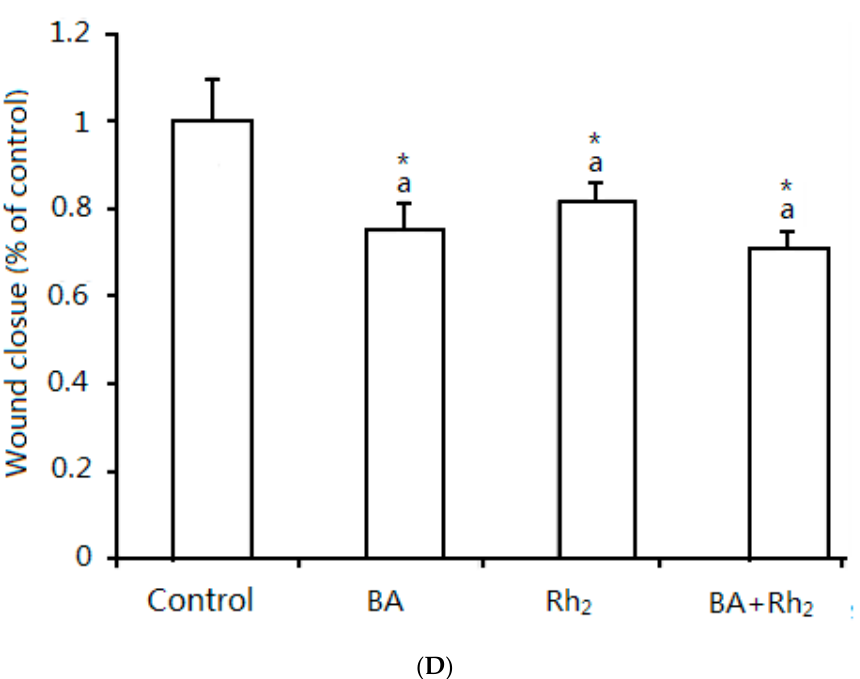
Figure 2. For the scratch assay, wounds were made when MDA ( A , B ) and MCF-7 ( C , D ) cells were 90–100% confluent and after an overnight starvation. Cells were treated with vehicle control, 63.76 μ M BA, 57.53 μ M Rh 2 , or 25.20 μ M BA + 22.75 μ M Rh 2 for 24 h. The closure of wounds was imaged and measured at 0 and 24 h. An asterisk (*) indicates a significant difference from the control ( p < 0.05). * Compared to the control, p < 0.05. Different letters showed significant difference in sample groups ( p < 0.05).